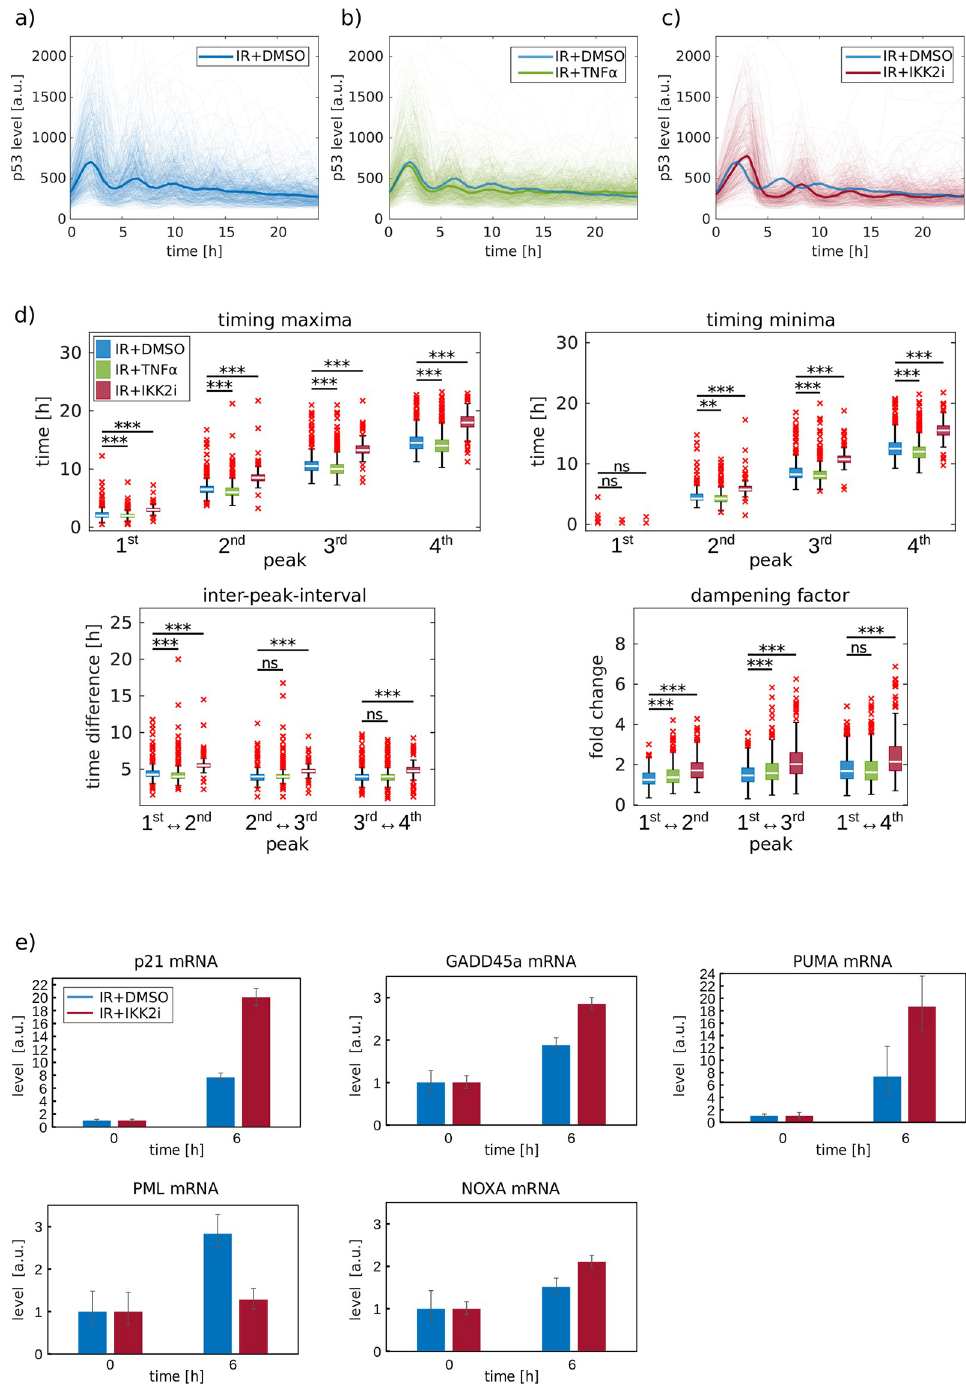
Fig 1. Activation status of NF- κ B affects the p53 response to DSBs. A549 reporter cells were tracked via live-cell time- lapse microscopy and the p53 median nuclear fluorescence intensity was measured in cells treated with 10 Gy irradiation (IR) in combination with DMSO (a), TNF α (b) or IKK2i (c). Light colored lines denote single cell trajectories whereas bold lines indicate the median of trajectories. d) Quantification of selected features (timing maxima, timing minima, inter-peak-intervals and dampening factor) of the first four p53 pulses. To test the significance of changes, we used the Wilcoxon rank sum test in combination with the Bonferroni-Holm method to correct for multiple testing, � p < 0.05, �� p < 0.01, ��� p < 0.001. e) mRNA expression of p53 target genes was measured upon 10 Gy IR in A549 cells treated with DMSO or IKK2i by qRT-PCR. β -actin was used as an internal control. Data were normalized to values of the sample